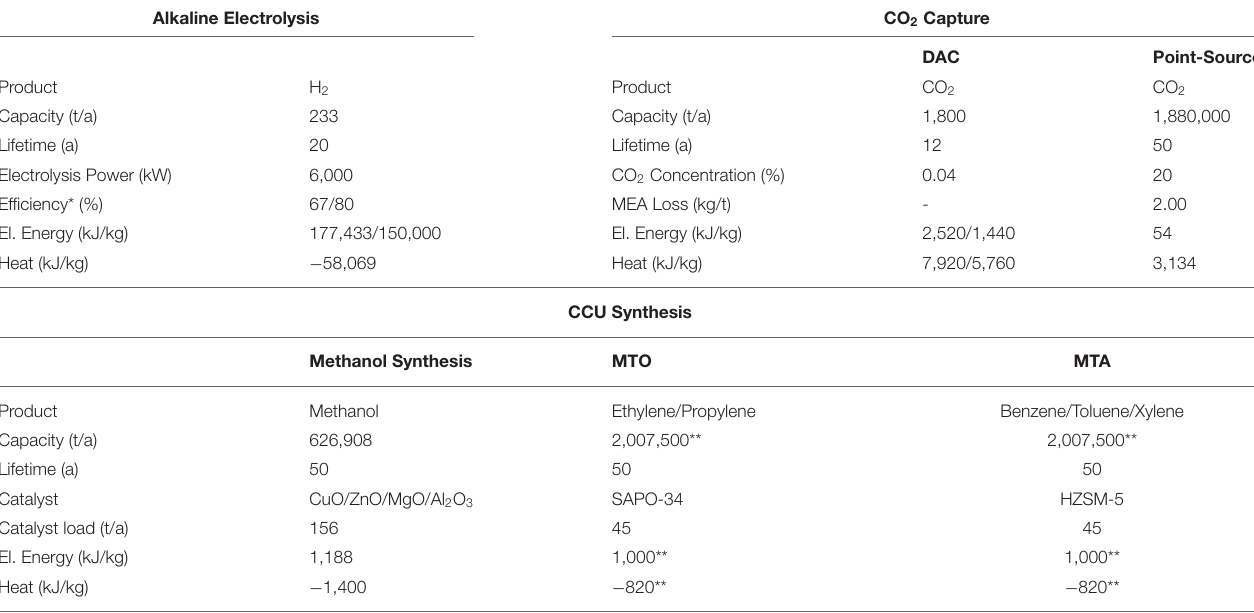
TABLE 3 | Technological parameters of alkaline electrolysis, CO 2 capture, and CCU synthesis modules. Alkaline